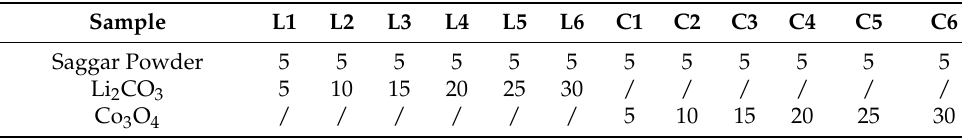
Table 1. Experimental values and raw material consumption